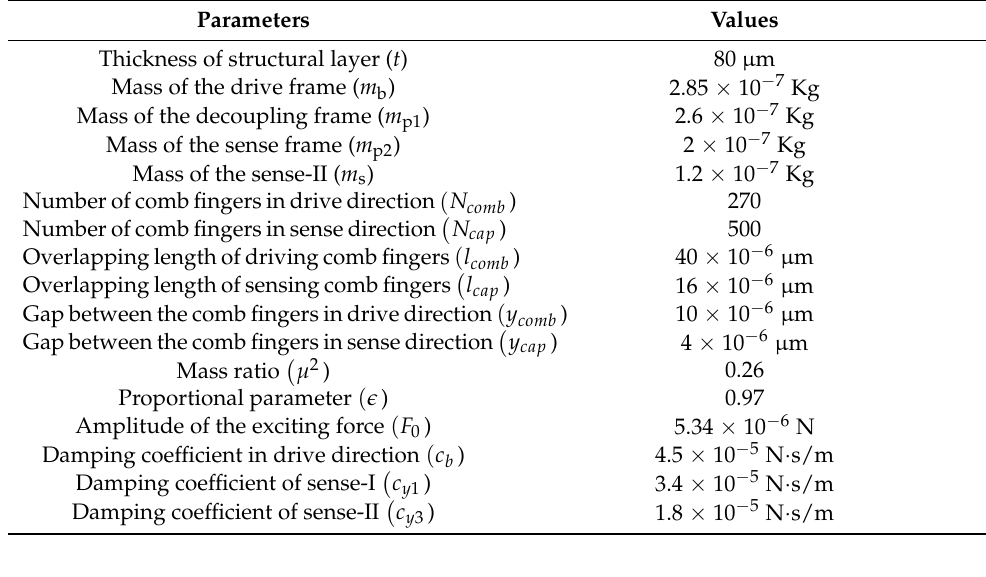
Table 1. The parameters of the micro-gyroscope.